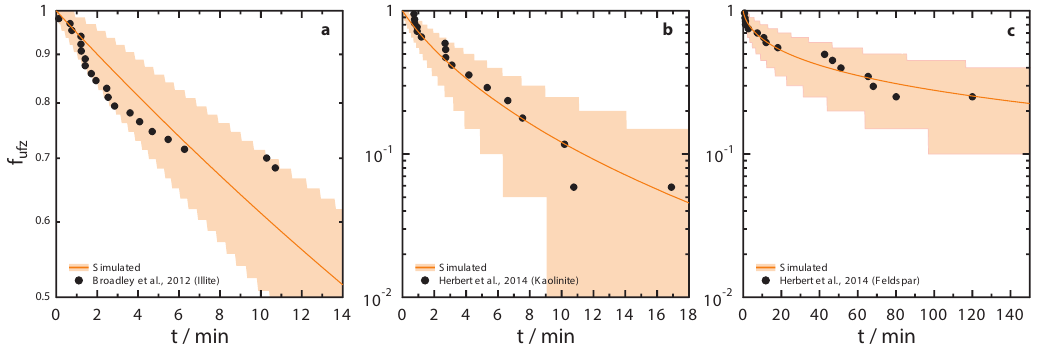
Figure 2. Simulated and experimentally (Broadley et al., 2012; Herbert et al., 2014) derived unfrozen droplet fractions, f ufz , as a function time, t . Model simulations and INP types used are (a) IsoBR and illite, (b) IsoHE1 and kaolinite, and (c) IsoHE2 and feldspar, respectively. Orange lines and shading represent f ufz with corresponding 5th and 95th percentile bounds, respectively. Parameter values for model simulations are given in Table